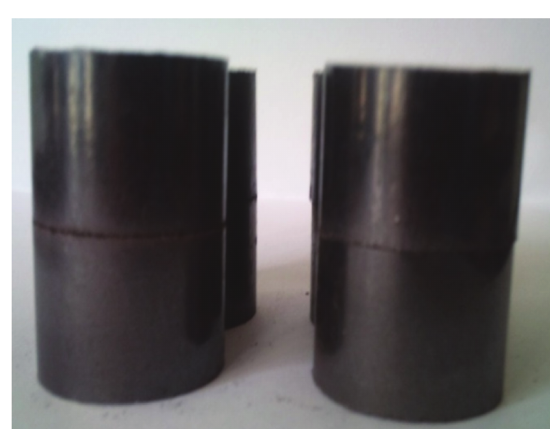
Figure 5: SSD briquette samples.